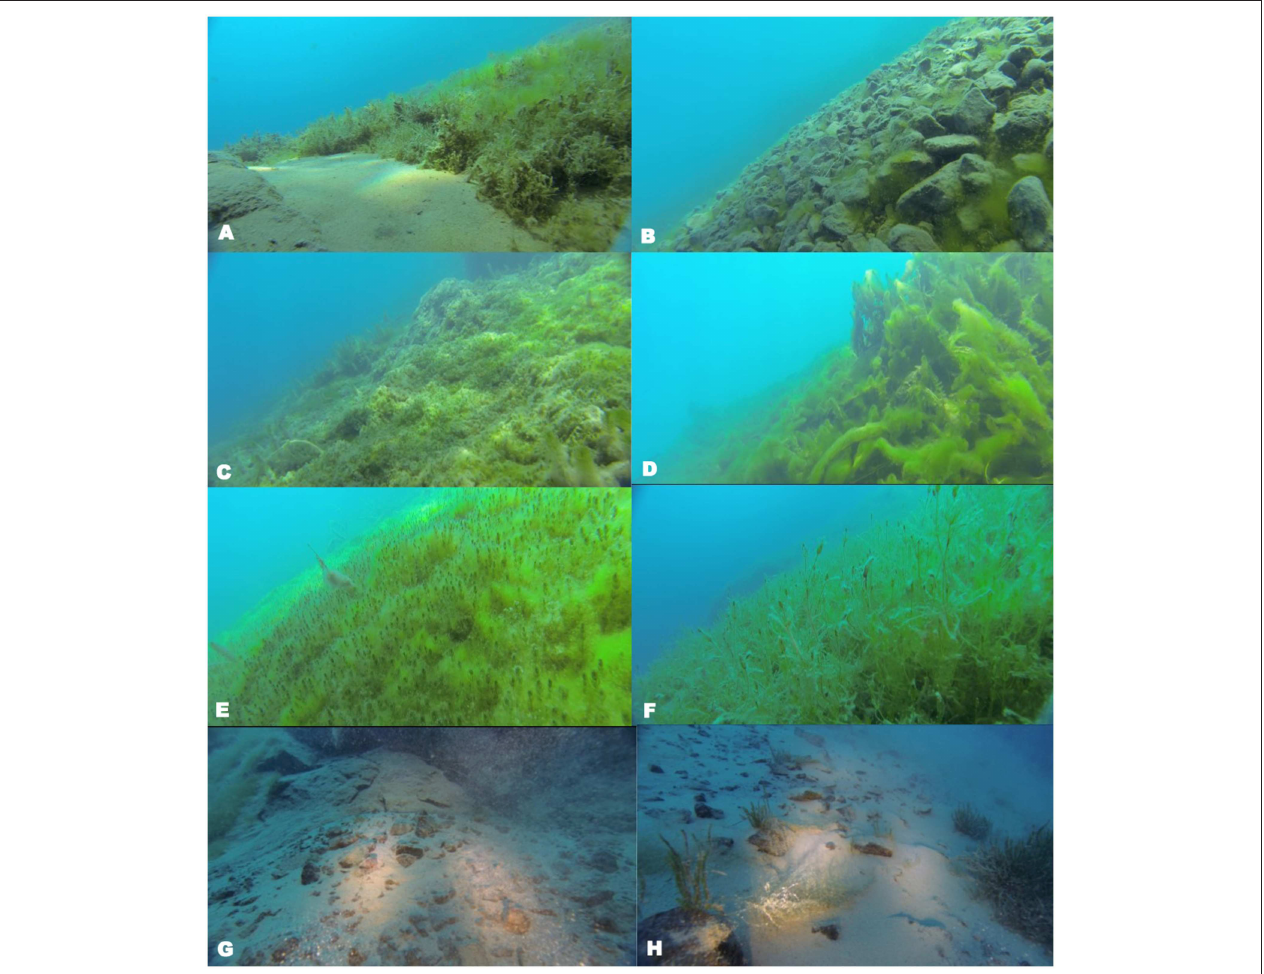
FIGURE 7 | Images from the 2013 video surveys and jump dives illustrating representative habitats and associated biotic communities observed at different depths. (Timings refer to time lapsed on video recordings). (A) Amazon Cave video transect part 1 (08:02): slope 20–40 ◦ , 5–10m depth, rock and sediment, Myriophyllum sp. (M. quitense?) and small Nitella sp. (N. acuminata?, N. flexilis?), Chara sp. (C. globularis?, C. rusbyana?) . (B) Dive peninsula west shore profile (11:42): slope 40–55 ◦ , 10–20m depth, stony mass of fallen rocks with a thin layer of filamentous bright green algae Cladophora sp. and oligochaete worm. (C) Dive peninsula west